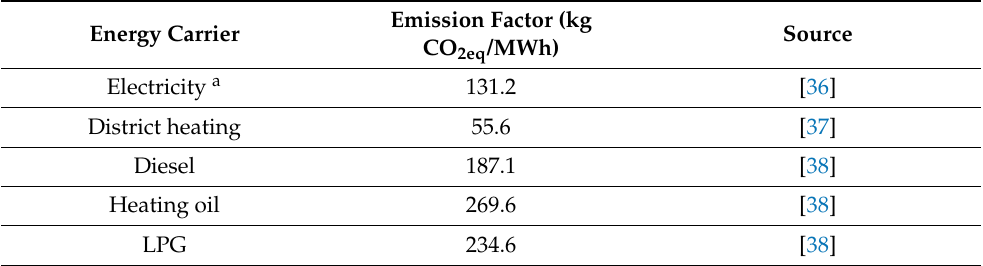
Table 1. The emission factors used for allocating GHG emissions at the process level. Emission Factor (kg Energy Carrier CO 2eq /MWh)